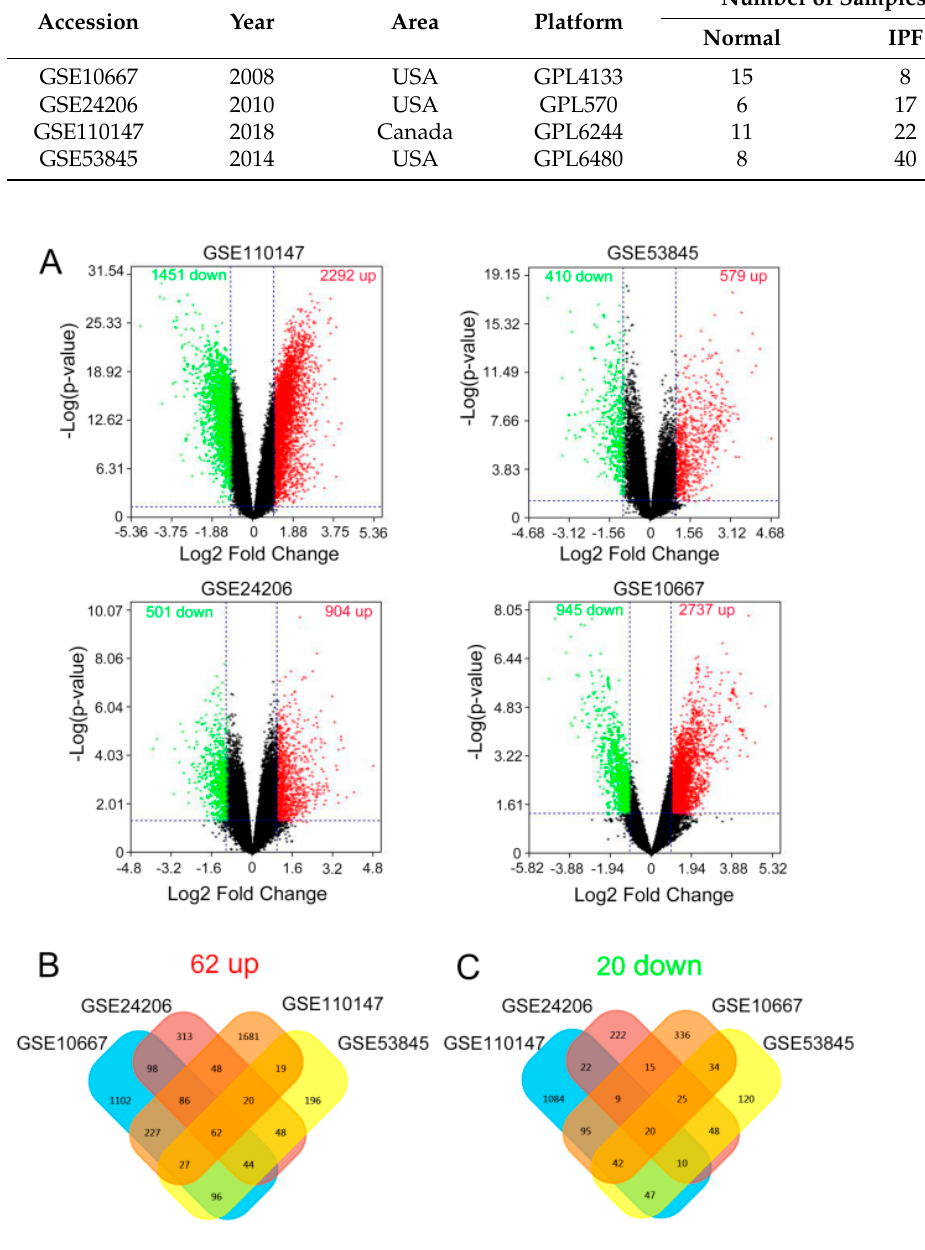
Figure 1. The results of differentially expressed genes (DEGs) in four cohort profile data sets (GSE110147, GSE53845, GSE24206, and GSE10667). ( A ) Volcano plot visualizing the DEGs. The x axis indicates the fold change (log-scaled), whereas the y axis shows the p -values (log-scaled). Vertical lines represent either upregulation or downregulation by 2-fold. The horizontal line represents a p -value = 0.05. Red points represent upregulated (up) genes, black points stand for no-significantly-changed (NSC) genes, and green points represent downregulated (down) genes. ( B ) Venn diagrams of the DEGs. Cross areas indicate the commonly upregulated DEGs, and ( C ) cross areas indicate the commonly downregulated DEGs.